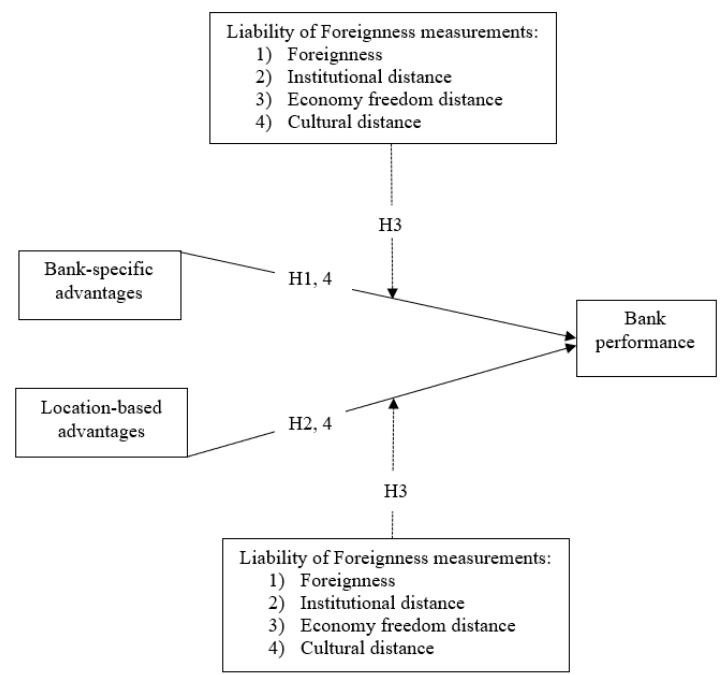
Figure 1. Conceptual framework.